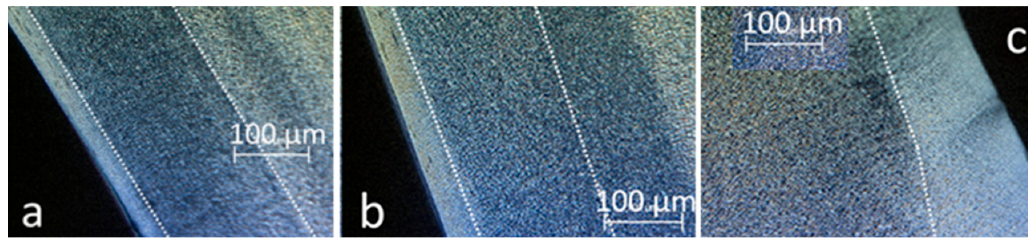
Figure 9. Microscope observations of the plaque: ( a ) 60 mm away from the gate; ( b ) 225 mm away from the gate; ( c ) 275 mm away from the gate.